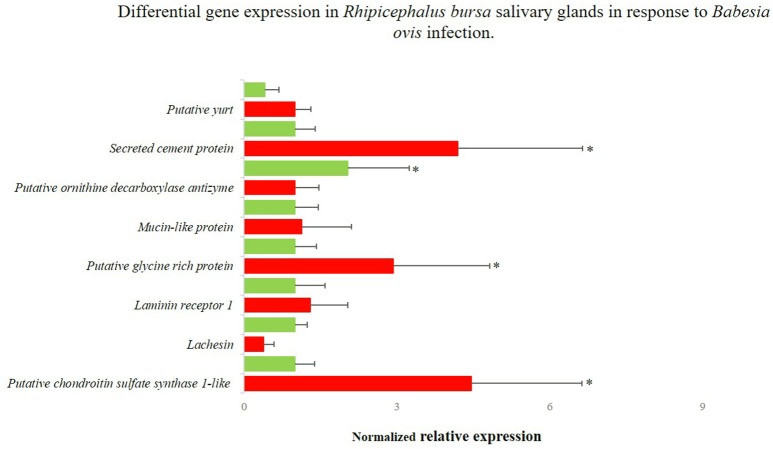
Differentially gene expression of Rhipicephalus bursa SG in response to Babesia ovis infection evaluation by qPCR. Red bars represent the B. ovis infected SG and green bars represent the SG from uninfected R. bursa ticks. *P < 0.05.